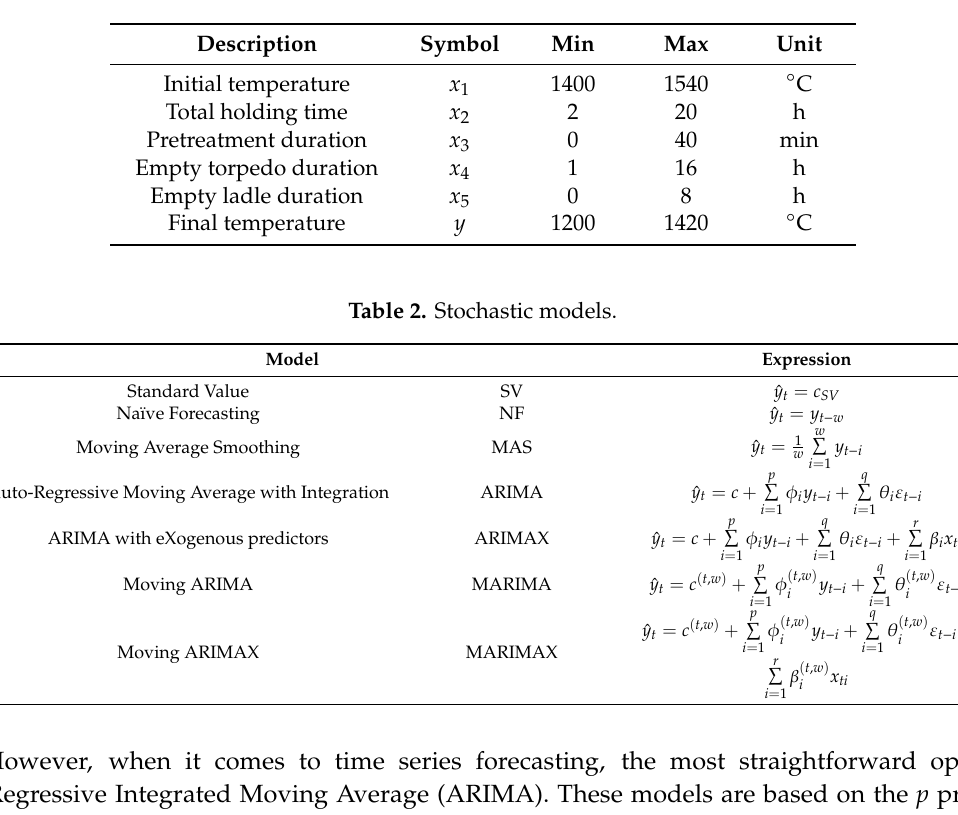
Table 1. Considered variables for BF–BOF interface models.